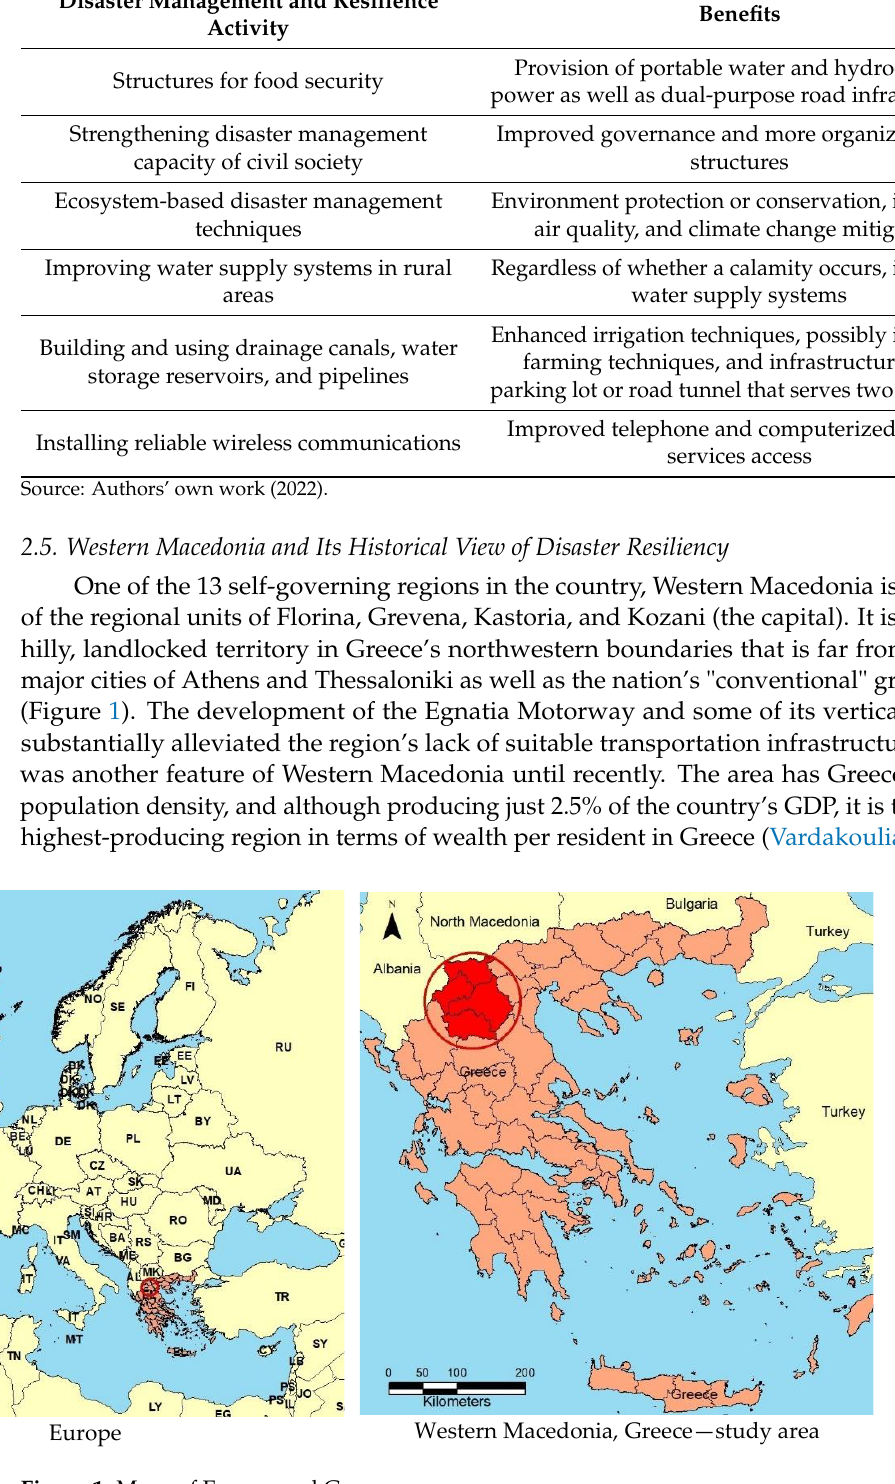
Figure 1. Maps of Europe and Greece.